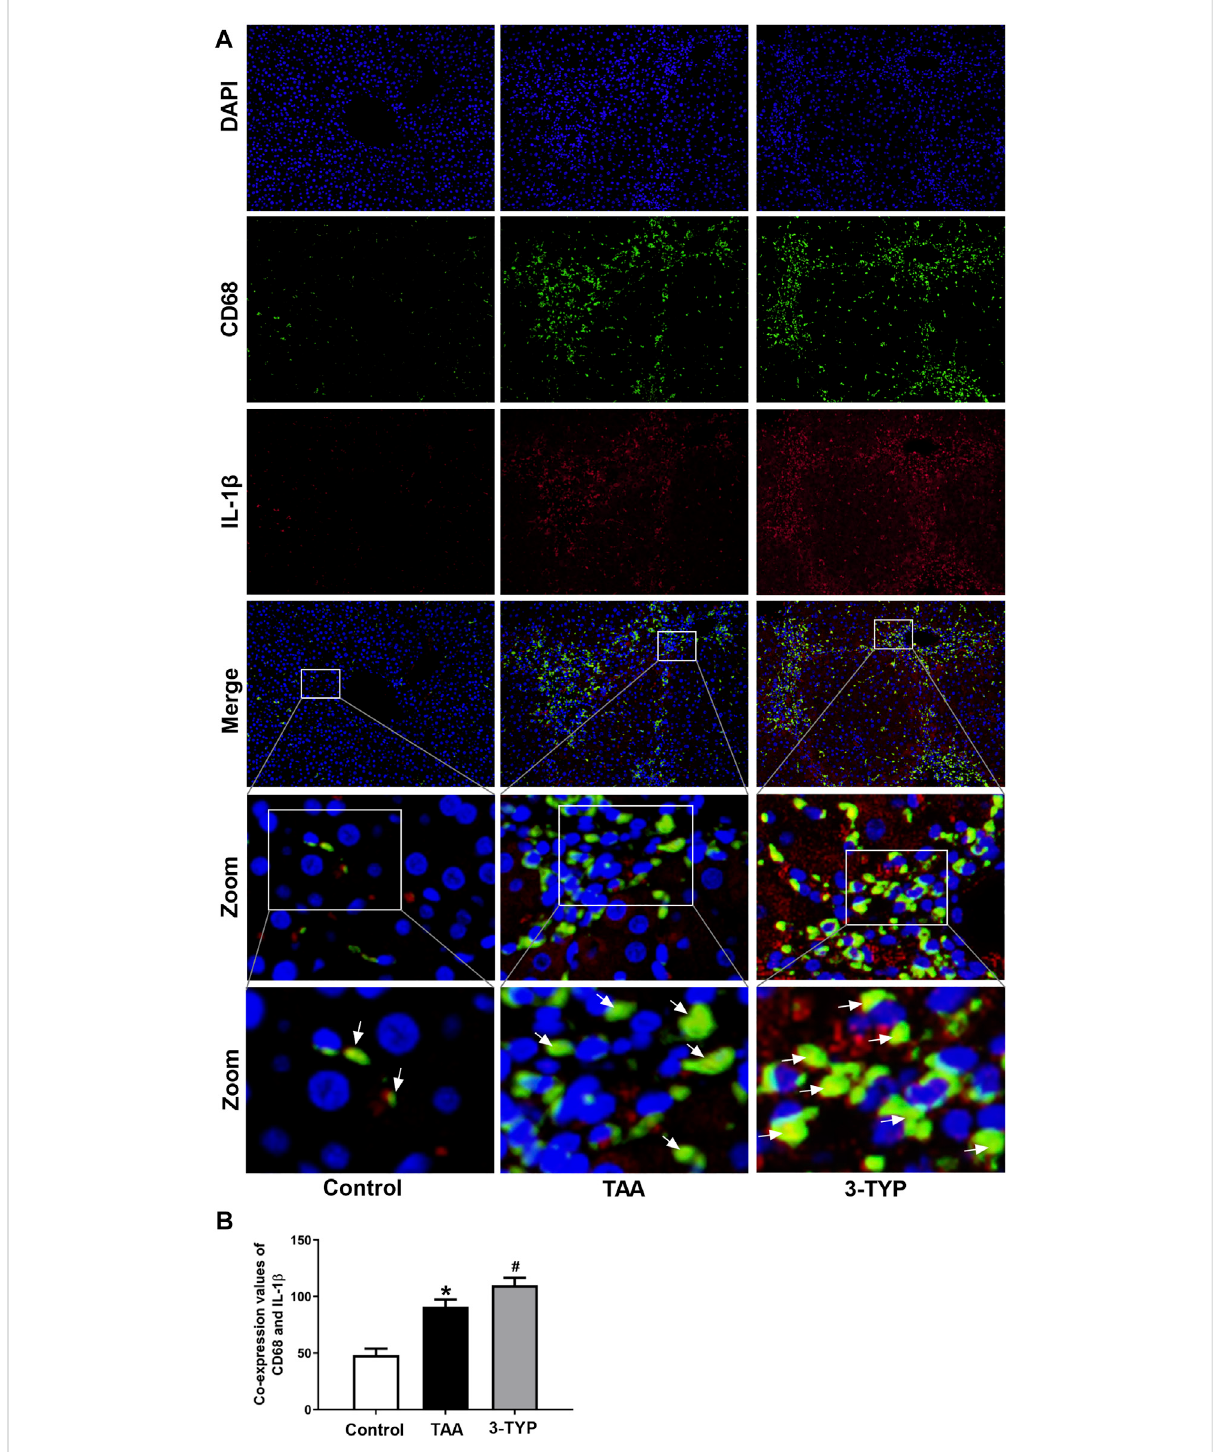
Effect of 3-TYP on the macrophage expression of IL-1 β in each group, n = 10 per group. (A) Double immuno fl uorescent staining with macrophage marker anti-CD68 (green) and anti-IL-1 β (red). (B) the quantitative co-expressions of CD68 and IL-1 β . * p < 0.05, vs . the control group. # p < 0.05, vs . the TAA group. → the co-localization of CD68 and IL-1 β